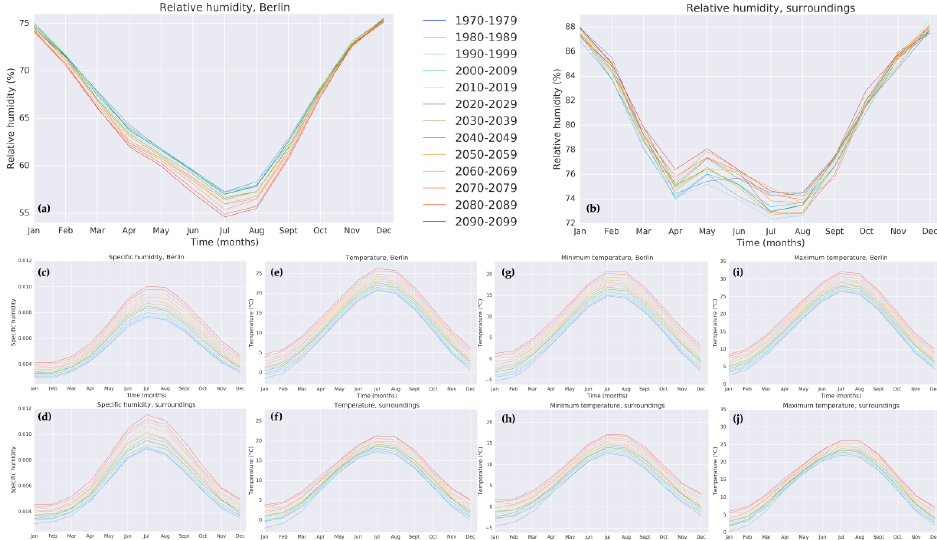
Figure 6. Decadal annual mean cycle for the period 1970 – 2100 of the EURO-CORDEX multi-model ensemble for RCP 8.5 and for Berlin and its surroundings. The figure shows the outcomes for the different variables: RH ( a/b ), SH ( c/d ), temperature ( e/f ), minimum temperature ( g/h ), and maximum temperature ( i/j ).